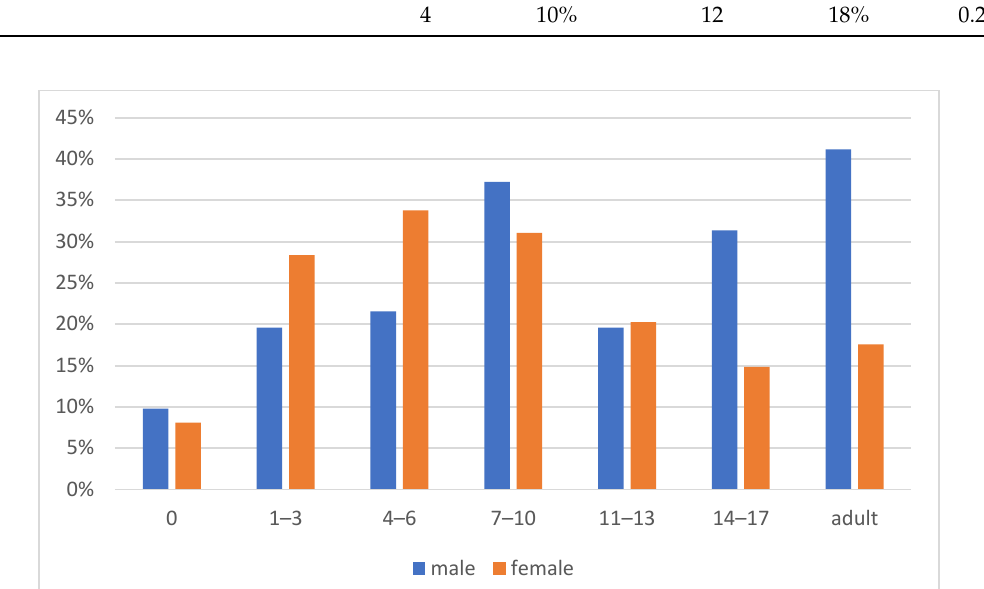
Figure 2. Children’s age groups (years) of the respondents, for both genders (differences between the groups were not significant except for those having grown-up children, with p < 0.01). Table 1. Basic parameters of the respondents.